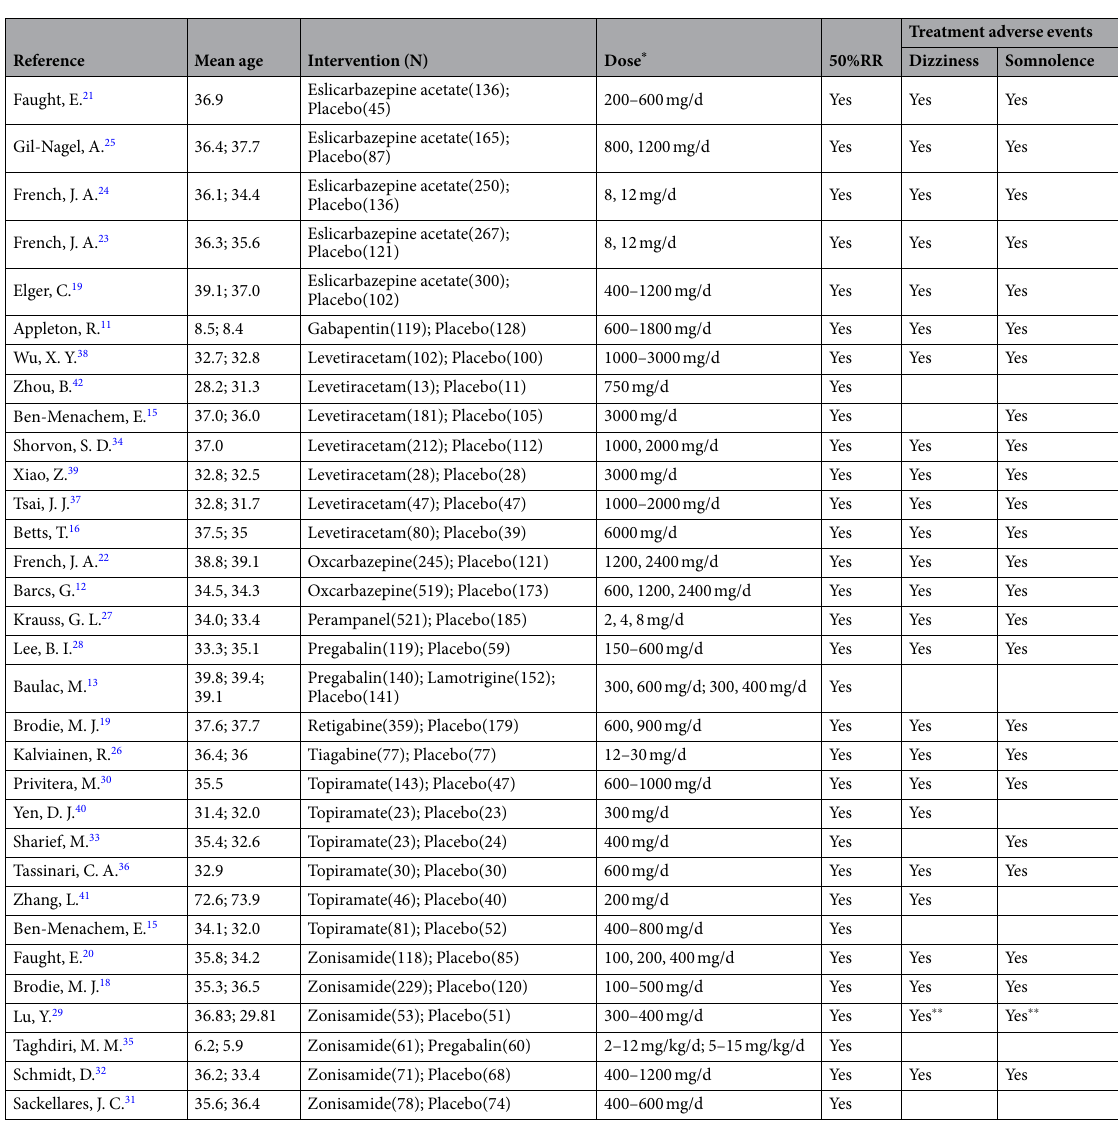
Table 1. Basic characteristics of included clinical trials. * Dose for placebo not specified; ** Numbers of patients are 52 and 50 for Zonisamide and placebo